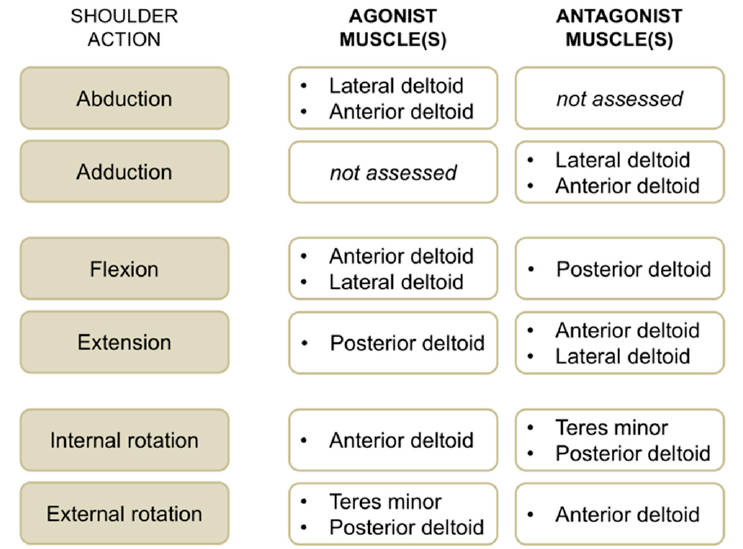
Figure 3. Overview of shoulder actions with respective agonist and antagonist muscles evaluated with surface electromyographic (EMG) activity in this